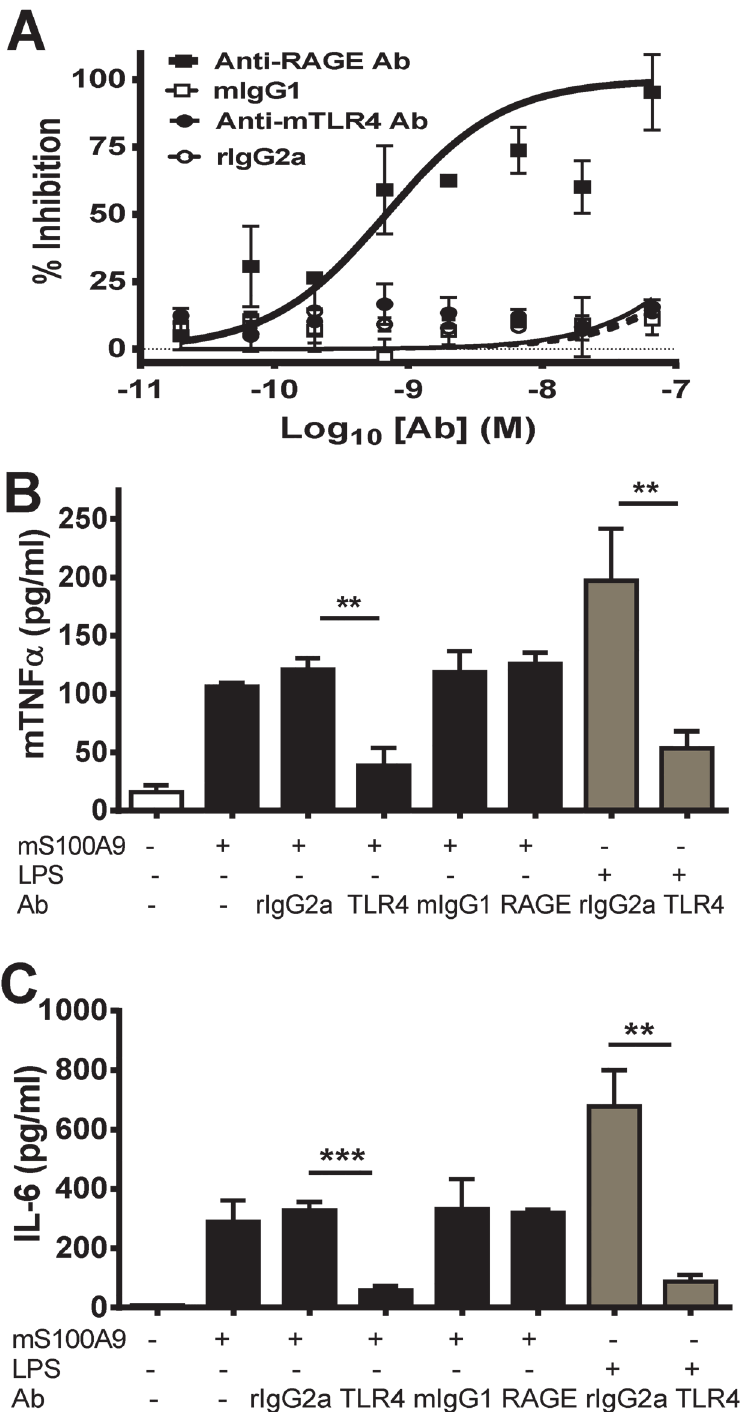
Fig 5. Effect of RAGE and TLR4 blockade on murine S100A9 induced RAW cell migration and proinflammatory cytokine induction. (A) Murine S100A9 (1 ng/ml) was used to induce the migration of RAW cells treated with dose titrations of anti-RAGE, anti-murine TLR4 Ab or isotype control Abs. Percentage inhibition is relative to no Ab treatment. Murine S100A9 (10 μ g/ml) or LPS was used to induce TNF α (B) and IL-6 (C) from RAW cells with or without anti-RAGE, anti-mTLR4/MD2 or control Abs. Unpaired T-test was used to determine if the anti-RAGE or anti-mTLR4/MD2 treatments were significantly different from the control Abs for each treatment group ( * P < 0.05, ** P < 0.01, *** P < 0.001). Data shown is mean ± SDEM of triplicate samples from a representative of three independent experiments.